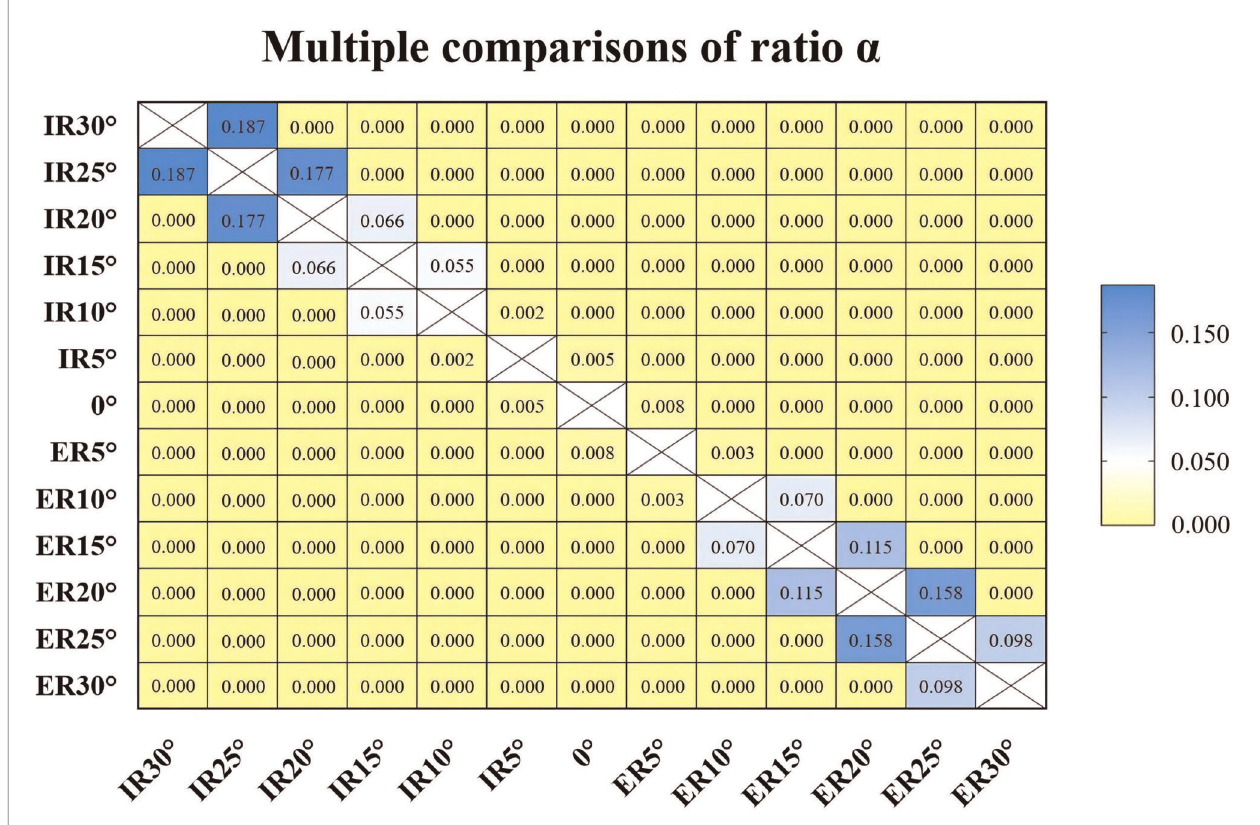
FIGURE 6 | Tamhane ’ s T2 test was selected according to the data type. The cells with p value >0.05 were blue, indicating that there were no statistical signi fi cances between the groups. The cells with p value <0.05 were yellow, indicating that the statistical differences were signi fi cant between groups.